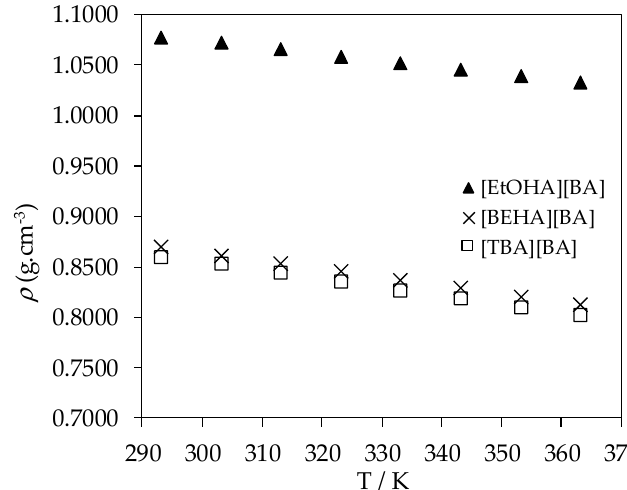
Figure 3. Plot of experimental density ( ρ ) values of [EtOHA][BA], [BEHA][BA], and [TBA][BA] as a function of temperature.